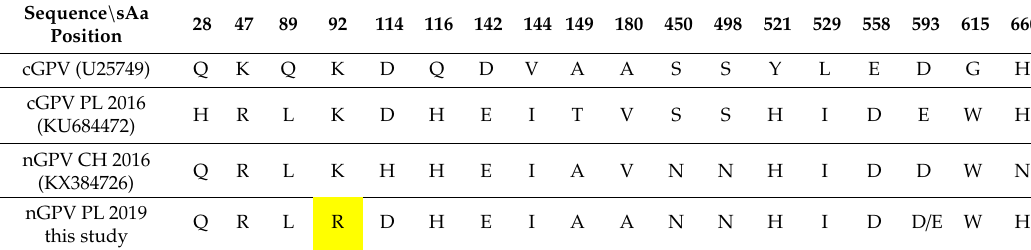
Table 2. Amino acid substitutions in Vp1 protein.